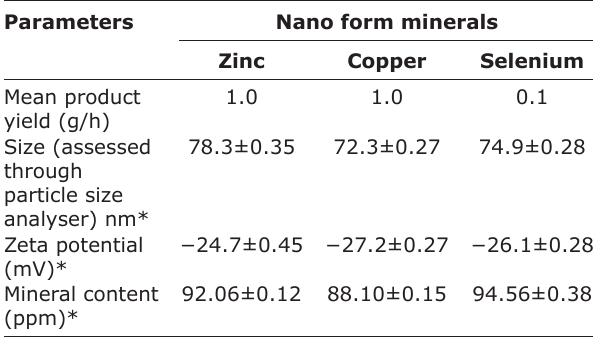
Table-2: Ingredient and nutrient composition of the experimental rations. Ingredients